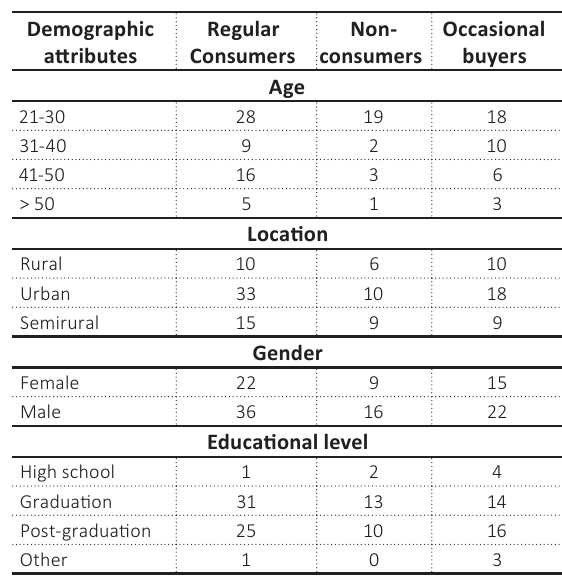
Table 7. Cross-tabulation of demographic variables and the